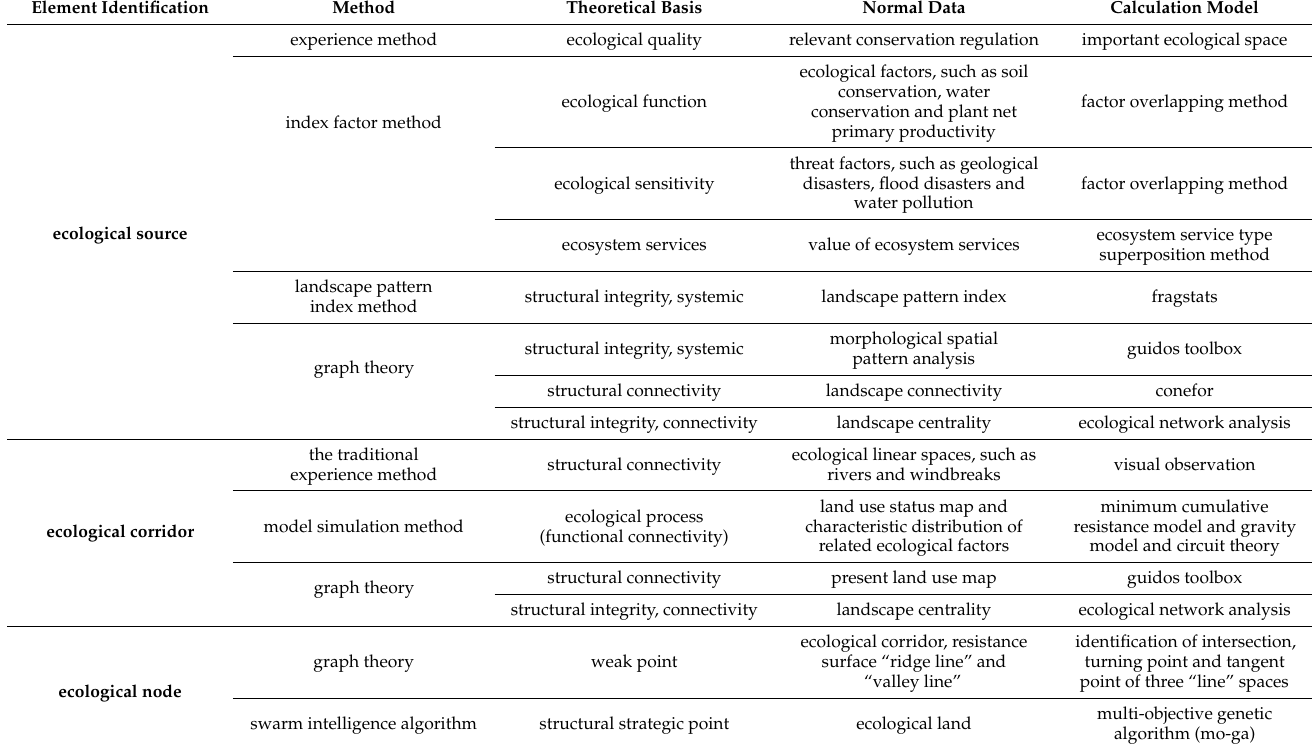
Table 1. Construction methods and models of ecological